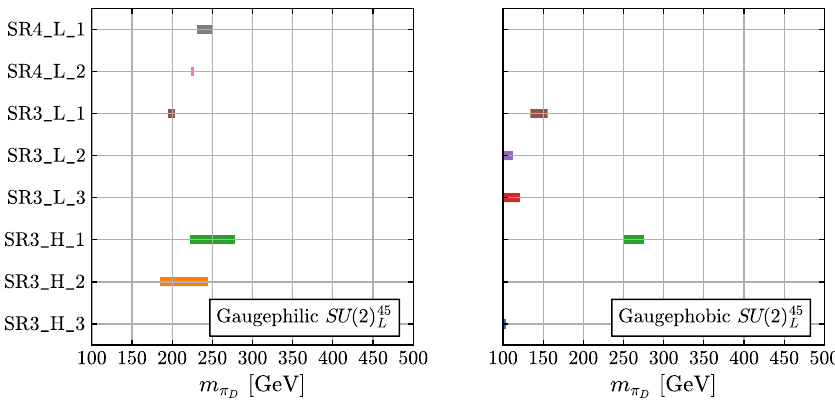
Figure 11 . Out of the 192 signal regions defined in the CMS multilepton search [150], 8 regions constrain some part of the dark meson parameter space. The excluded mass ranges are colored according to the denoted signal region. The regions labeled SR3 and SR4 regions contain either 3 or 4 leptons, respectively. The L or H denotes whether the scalar sum of the p jets is less than 200 GeV or greater than 200 GeV. While there are different cuts concerning the number of b -jets or taus, all of the constraining regions require either E miss 100 E miss T ≤